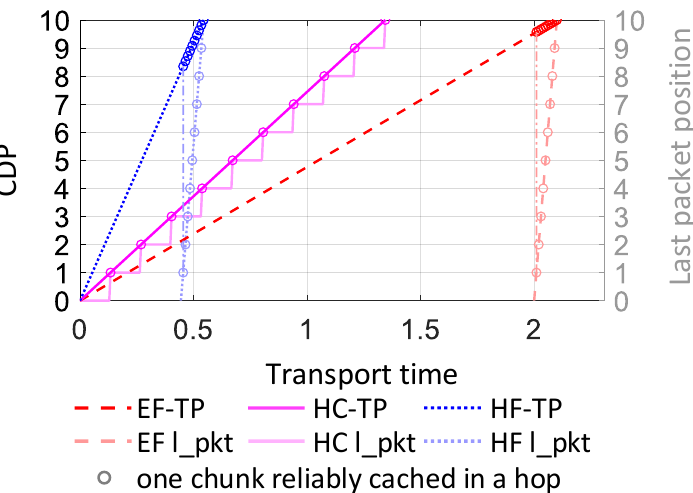
Figure 12. CDP occupancy and cache completeness during